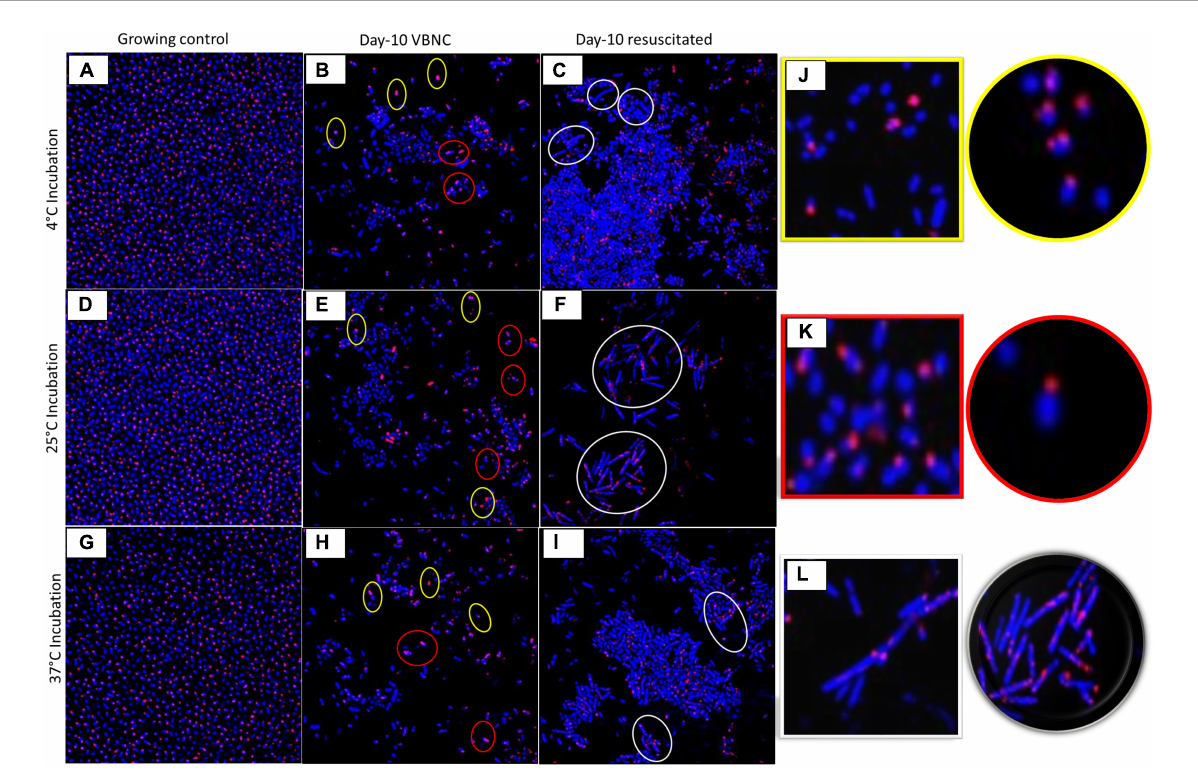
FIGURE4 Morphological changes of viable-but-non-culturable (VBNC) and resuscitation state. Morphology of VBNC and resuscitated state in terms of shape and size was compared with growing bacteria under confocal laser scanning microscopy (CLSM) in Acinetobacter baumannii in different growth conditions at 4 ◦ C (A–C) , 25 ◦ C (D–F) , and at 37 ◦ C (G–I) (for Klebsiella pneumoniae and E. coli, refer Supplementary Figures 4–6 ). Growing control bacteria (A,D,G) , Day 10 VBNC (B,E,H) , and Day 10 resuscitated (C,F,I) at temperature 4,25 and 37 ◦ C. FA treated day 4 VBNC and resuscitated (refer Supplementary Figure 4 ). Morphology altered in VBNC and resuscitated state (J) Yellow highlight shows cocci-shaped bacteria, (J) red highlight shows reduced bacilli, (K) white highlight shows elongated cells (L) . All cells stained with DAPI showed blue color, and CTC-tagged live cells give red color. Bacteria in the VBNC state are smaller in size and become shorter rods and cocci as compared to the growing state ( J , yellow and K , red highlight). After resuscitation, bacteria became shrunken and elongated when compared to growing bacteria ( L , white